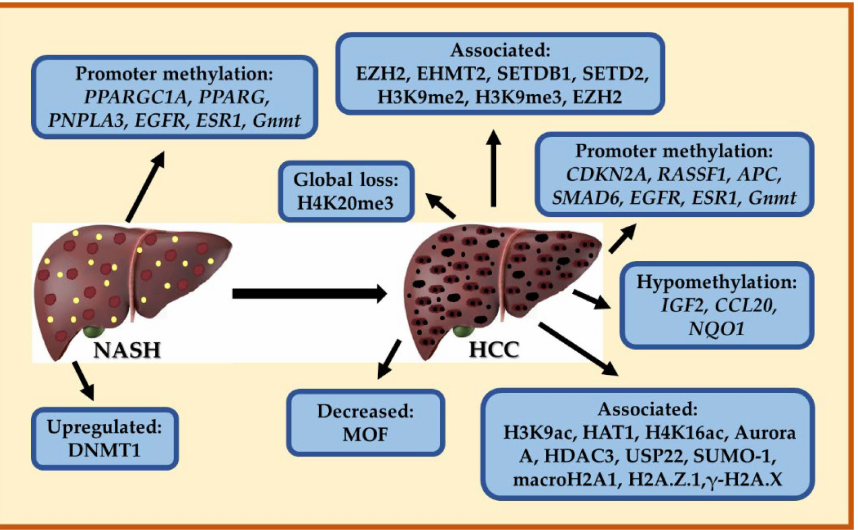
Figure 4. Representative epigenetic modifications in NASH and HCC. DNMT1 is essential for maintaining DNA methylation and is upregulated in NASH. Several genes have their promoter methylated in NASH and HCC. Other histone and mark modifications are involved in HCC, which are necessary to sustain tumor growth. Abbreviations: APC, adenomatosis polyposis coli; CCL20, C-C motif chemokine ligand 20; CDKN2A, cyclin dependent kinase inhibitor 2A; DNMT1, DNA methyltransferase 1; EGFR, epidermal growth factor receptor; ESR1, estrogen receptor 1; IGF2, insulin- like growth factor 2; Gnmt; glycine N-methyltransferase; NQO1, NAD(P)H: quinone oxidoreductase 1; MOF, males absent on the first; PNPLA3, patatin-like phospholipase domain-containing protein 3; PPARG, peroxisome proliferator activated receptor gamma; PPARGC1A, peroxisome proliferator- activated receptor gamma coactivator-1-alpha; RASSF1, ras association domain family member 1; SMAD6, SMAD family member 6; USP22, ubiquitin-specific protease